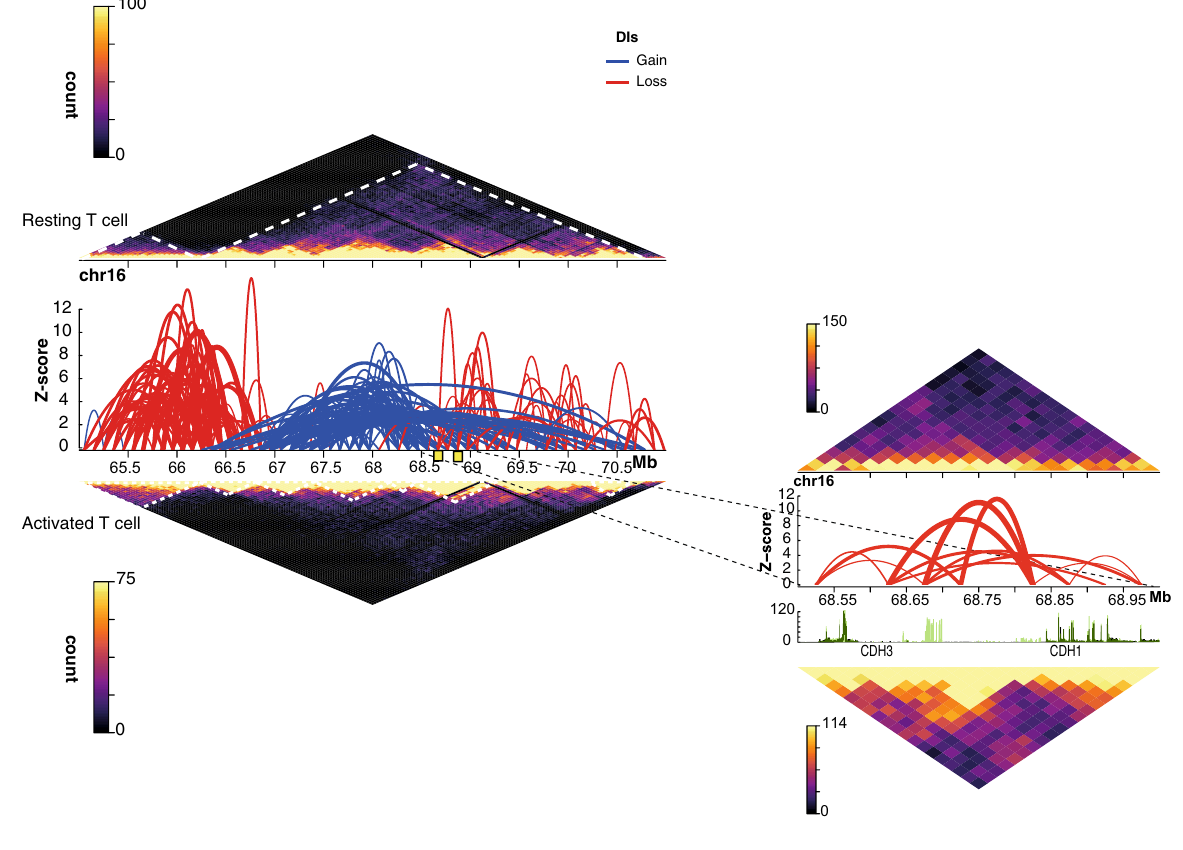
Figure 5. T cell activation results in partitioning of genome topology. In-situ Hi-C contact matrices plotted at 50 kbp resolution in resting and activated T cells over genes that have been associated with T cell activation such as CDH3 and CDH1. Colour scale of contact matrix indicates number of reads per bin pair. Locations of the TADs are marked by white dotted lines as called by TADbit. Significant differential interactions (DIs) as determined by the diffHic pipeline at 100 kbp (FDR < 0.05) are represented by arcs in the centre, where the vertical axis is the z-score (− log 10 p-value as calculated by edgeR). Each arc connects the two interacting bins and therefore identifies the relevant bin pair. Red and blue arcs represent strengthened (logFC > 0) and weakened (logFC < 0) DIs, respectively, in response to activation. The zoomed inset regions show in-situ Hi-C contact matrices and DIs at 25 kbp resolution (FDR < 0.05) and RNA sequencing coverage plots at the CDH3 and CDH1 loci. Light and dark green coverage plots represent activated and resting T cells,